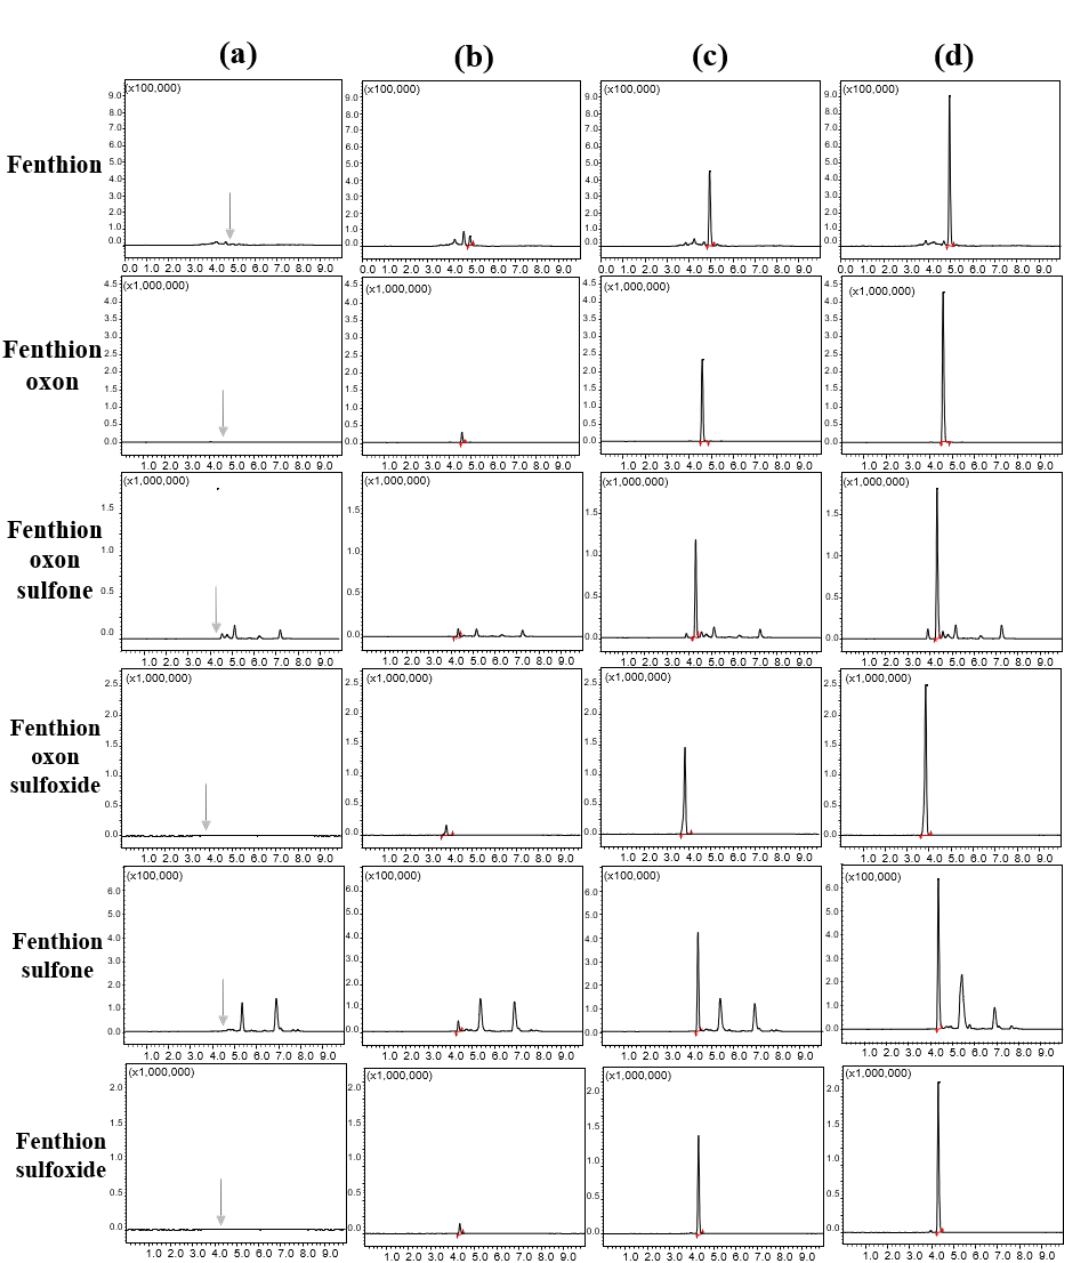
Figure 5. Representative UHPLC-MS/MS chromatograms for fenthion and its five metabolites: ( a ) unfortified brown rice, ( b ) brown rice fortified at 0.01 mg/kg, ( c ) brown rice fortified at 0.1 mg/kg, and ( d ) brown rice fortified at 0.2 mg/kg.